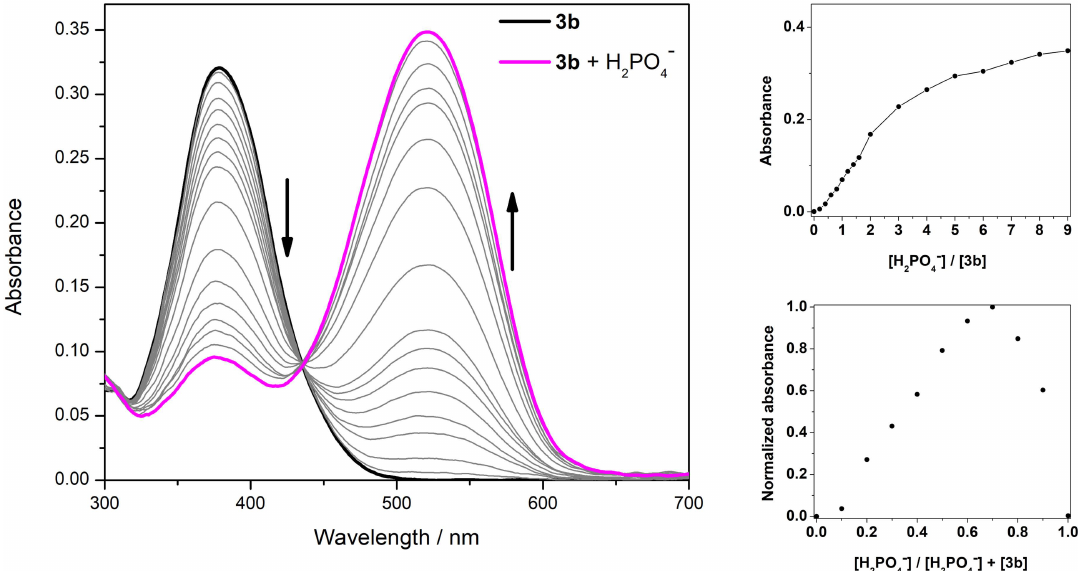
Figure 6. Photophysical interaction between compound 3b and H 2 PO 4 − (9 equiv. of H 2 PO 4 − re- quired for maximum absorbance). Left —spectrophotometric titration of compound 3b with H 2 PO 4 − ; Top right —absorbance at 520 nm as a function of added ion equiv.; Bottom right —Job’s plot for the interaction (stoichiometry 3b 1:2 H 2 PO 4 − ).